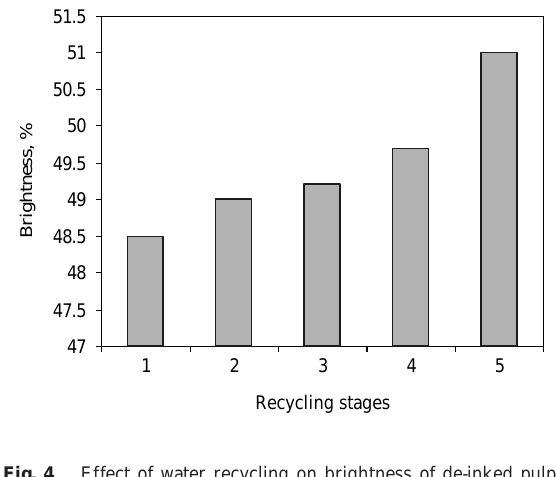
Fig. 4 Effect of water recycling on brightness of de-inked pulp (0.5% H